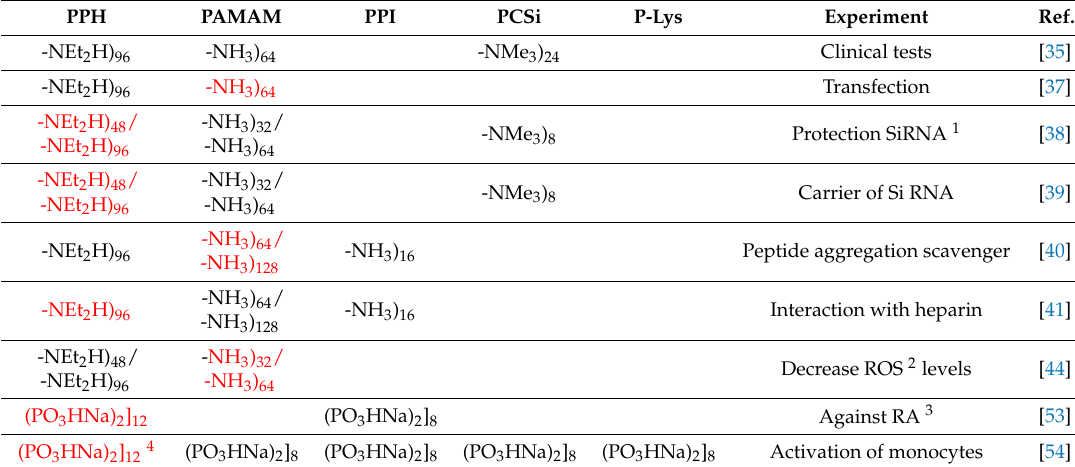
Table 1. Types of dendrimers, with the nature and number of their terminal functions, used for comparison in different biological experiments. The most efficient compound for each experiment is highlighted in